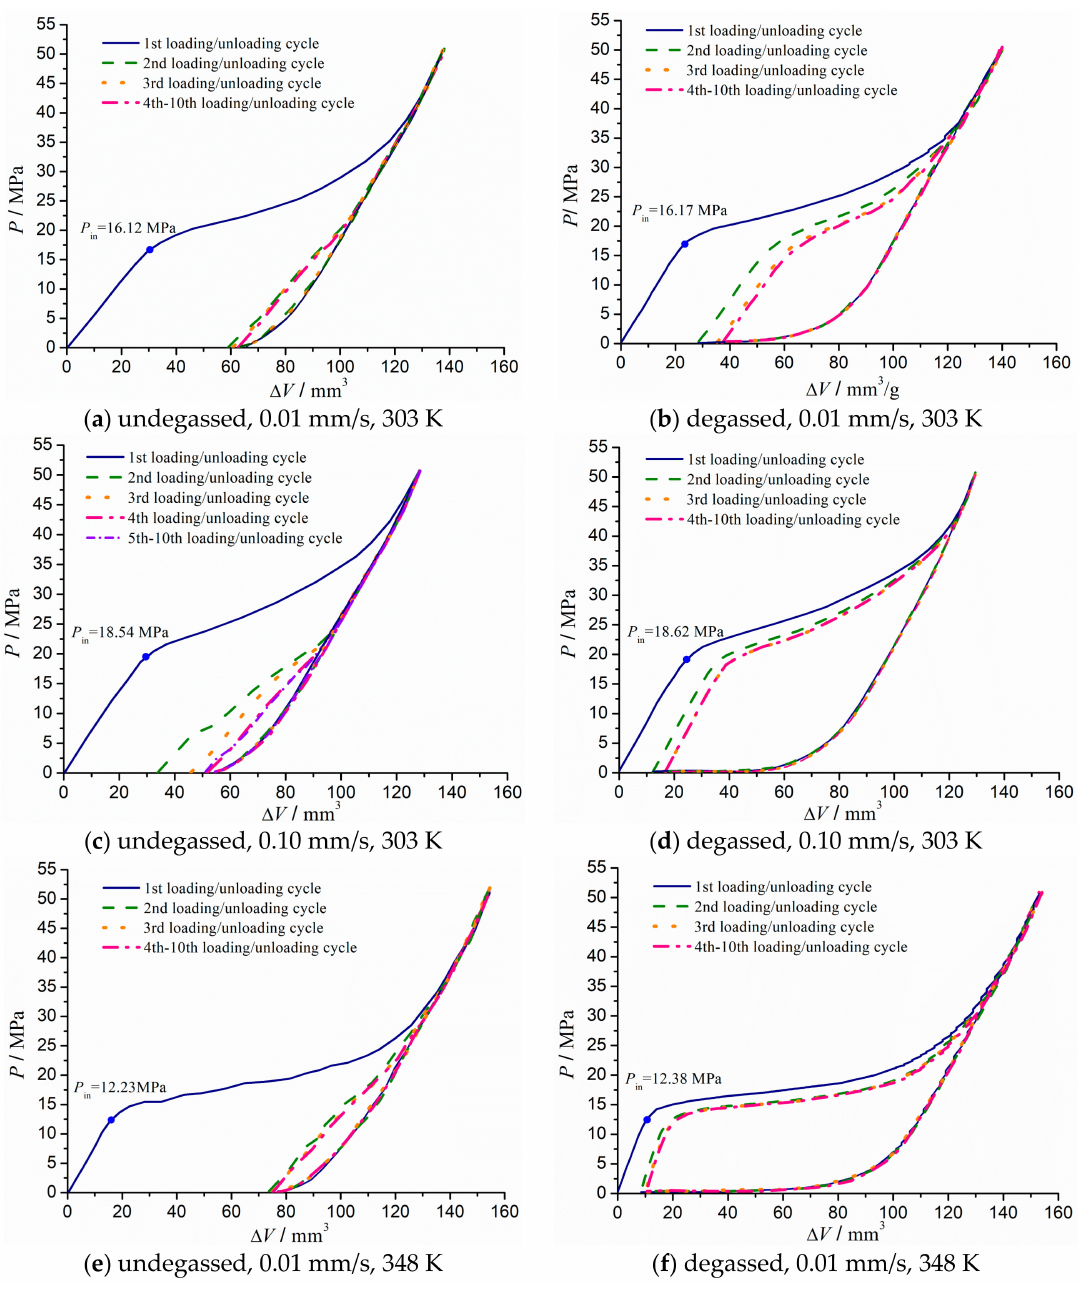
Figure 4. P - ∆ V curves of undegassed and degassed glycerol/zeolite system under ten cyclic loadings (loading rate 0.01 mm/s and 0.10 mm/s; system temperature 303 K and 348